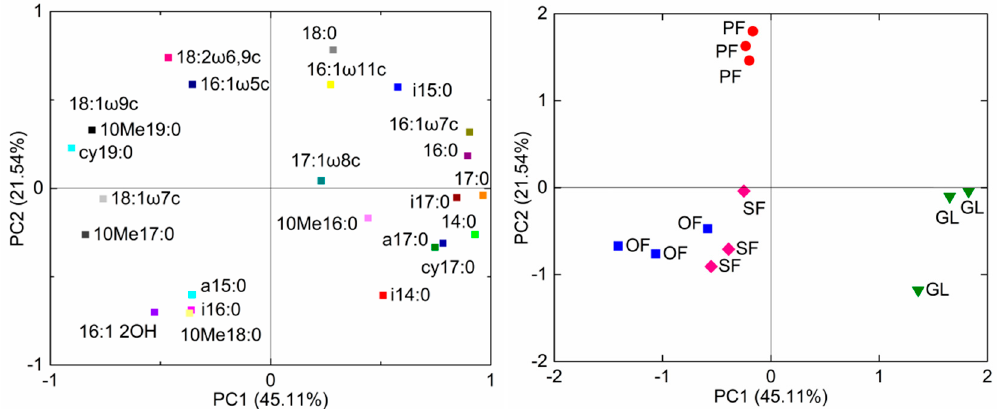
Figure 2. Principal component analysis (PCA) biplots of the phospholipid fatty acid (PLFA) (left) and microbial community composition in the soil samples from different land-use types (right). OF: old-growth forest; SF: secondary forest; PF: plantation forest; GL: grassland. Redundancy analysis (RDA) of the relationships between soil microbial community composition and soil physicochemical properties showed that the first axes, RD1, explained 45.44% of the total variance in soil microbial communities, while the second axes (RD2) explained 21.74% of the total variance (Figure 3).